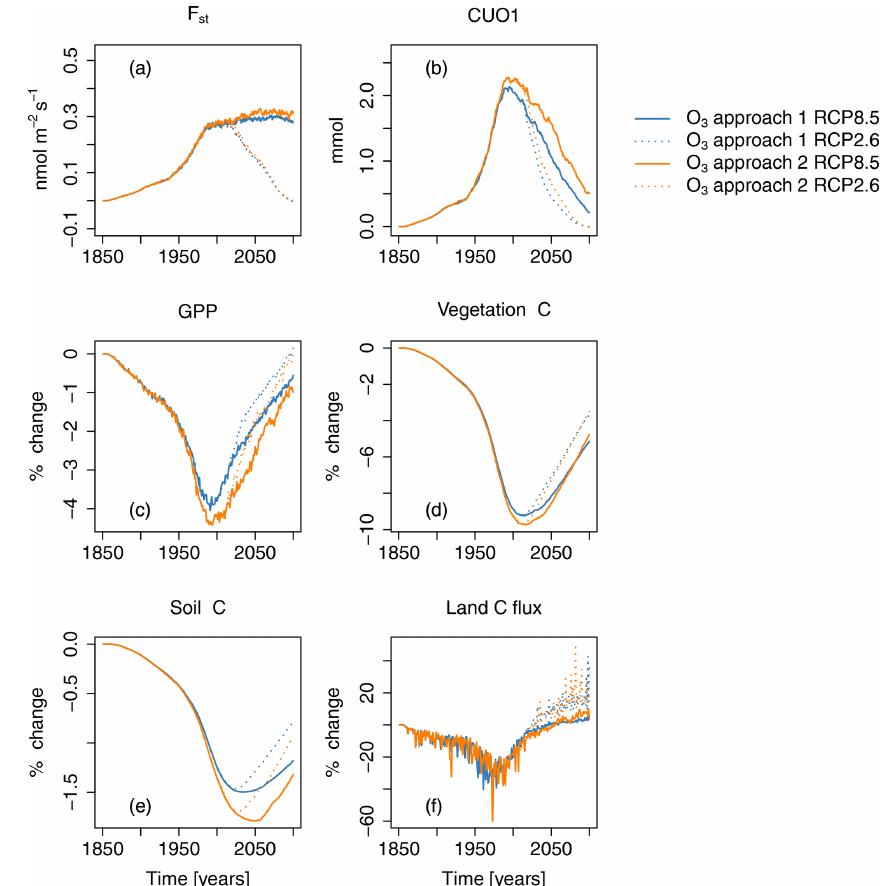
Figure 7. Ozone-induced absolute change in regional mean O 3 uptake ( F st ), mean cumulative O 3 uptake above a flux threshold of 1nmolm − 2 s − 1 (CUO1), and change in percent of summed GPP, total carbon biomass in vegetation (vegetation C), summed carbon soil organic matter (soil C), and summed land carbon flux (land C flux) compared to preindustrial values in the simulation region. Different colors indicate different approaches for calculating the O 3 -induced change from the factorial runs. Orange lines represent approach 1 – (S2 − S1) / S1; blue lines represent approach 2 – (S5 − S4) / S4. Solid lines indicate results from simulations based on RCP8.5, and dotted lines are results from simulations based on RCP2.6. The effect of the seasonal cycle is smoothed by the application of a moving average of 12